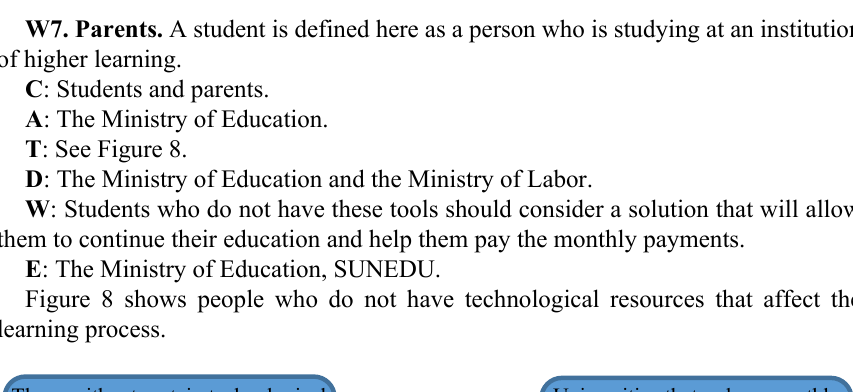
Fig. 7. Transformation and benefits of virtual classrooms